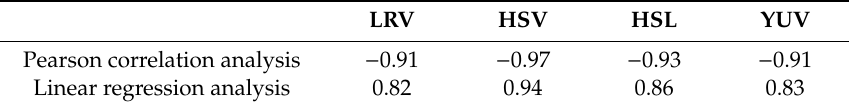
Table 6. Relationship between the color space technique and the indoor